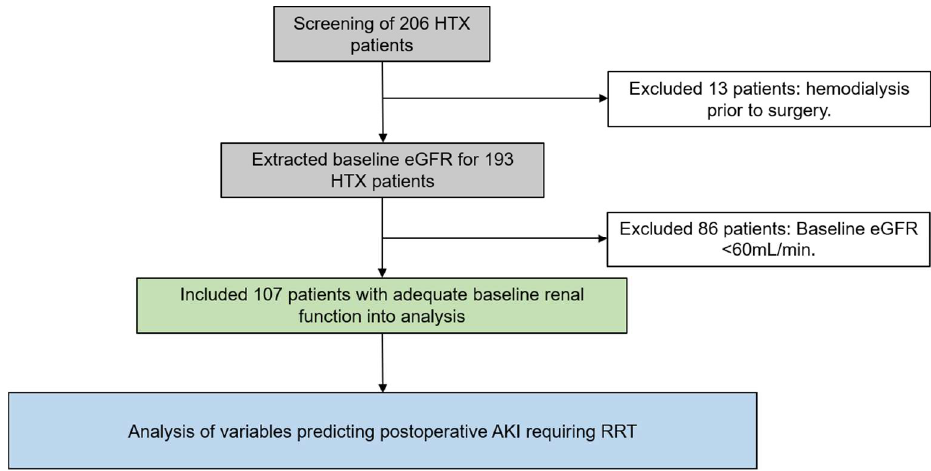
Figure 1. Study flow chart .